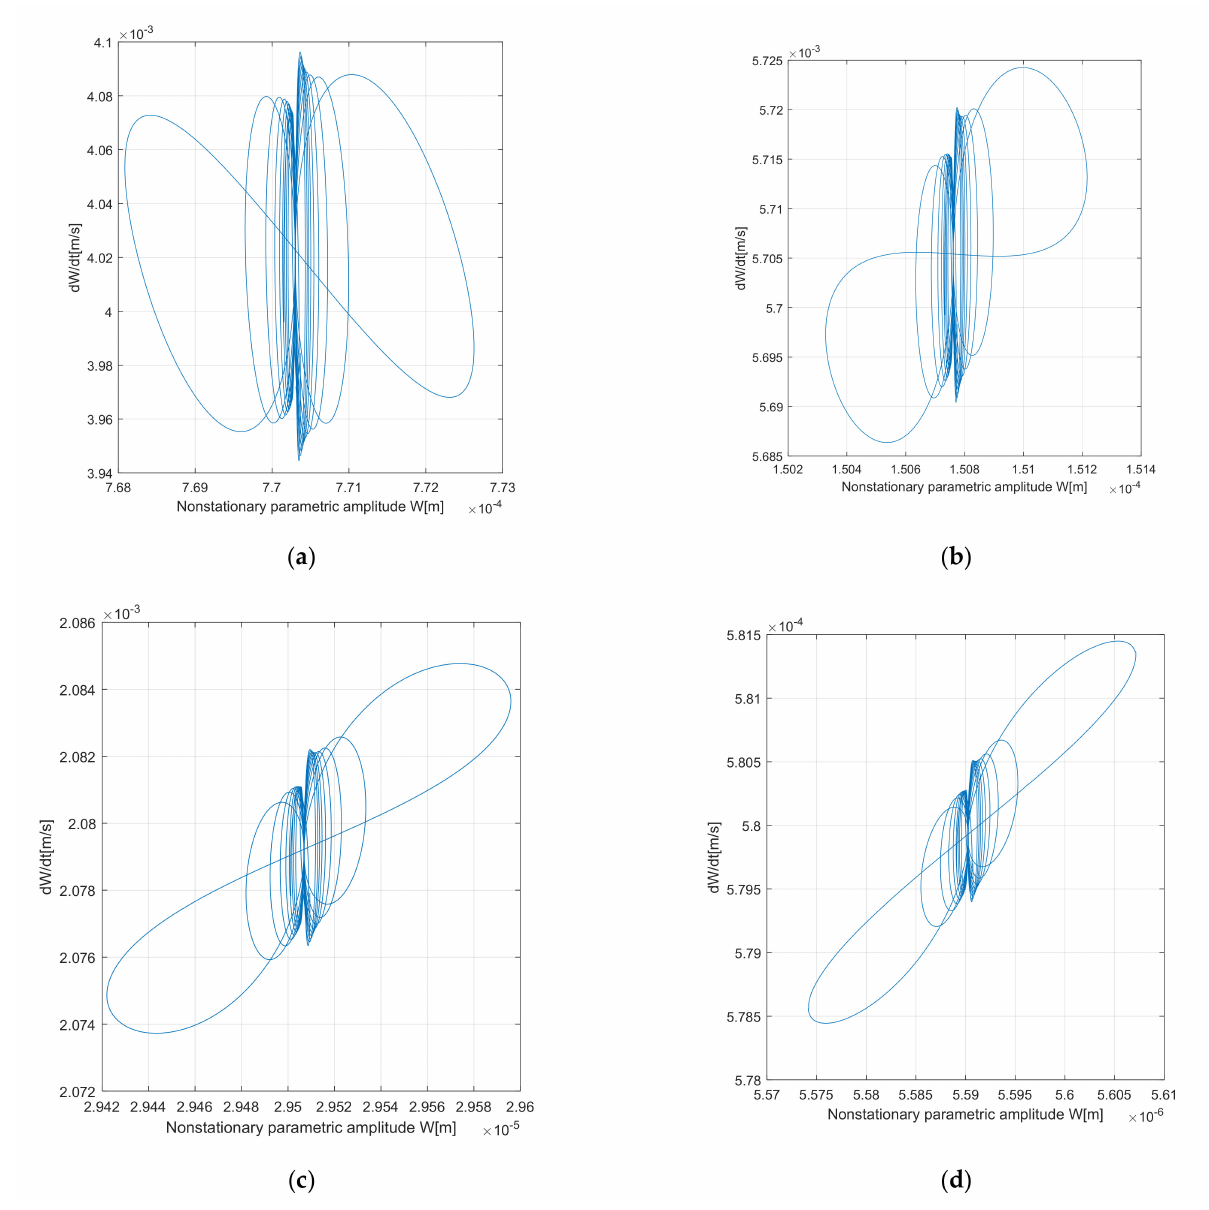
(cid:17) (cid:16) Figure 23. Phase space W, dW of the tulip for χ nT = 0.25, where µ = 0.623 × 10 − 4 . ( a ) ζ = 0.0016. dt ( b ) ζ = 0.0116. ( c ) ζ = 0.0216. ( d ) ζ = 0.0318. Here, m = 8 × 10 − 5